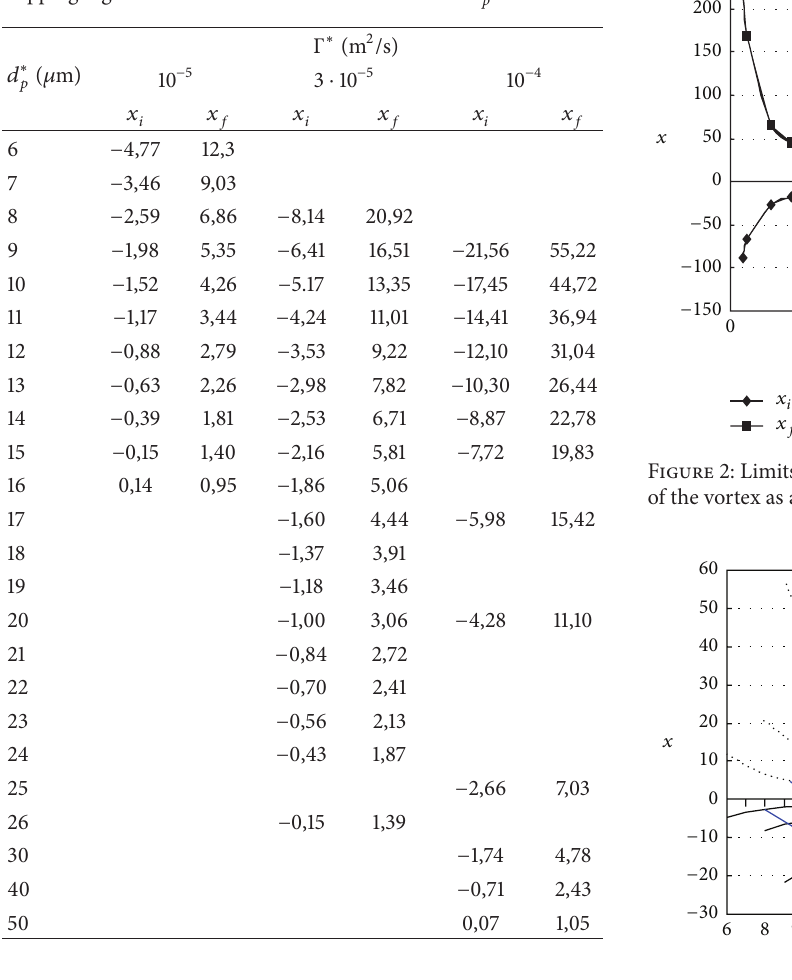
Table 2: Limit dimensionless values for the mesh of particles in the trapping region of a Rankine vortex as a function of 𝑑 ∗ 𝑝 and Γ ∗ .